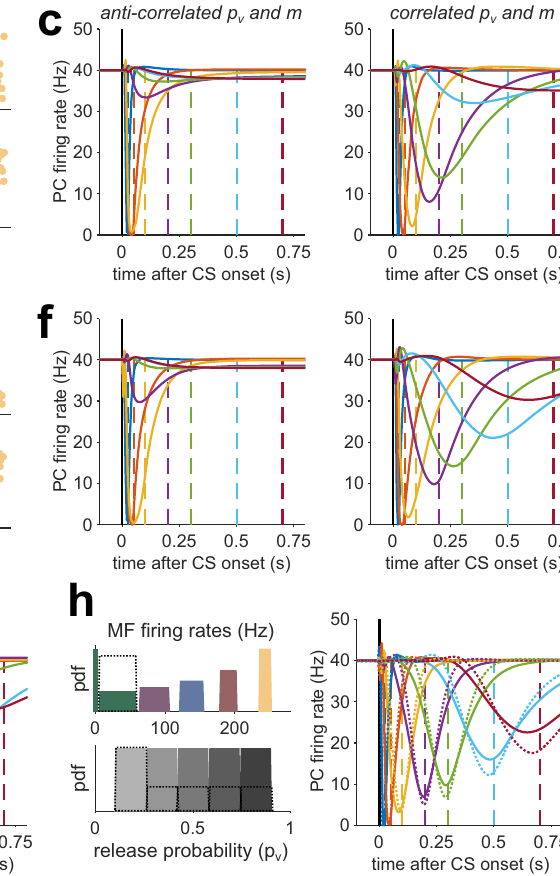
of n = 20 simulations with different realizations of MF patterns and MF-GC con- nectivity. d – f Same as ( a – c ), but for distributions divided into fi ve groups. g Left: MF rates and release probabilities for fi ve synapse types where the average group fi ring rate is as in ( d ), but the fi ring rate variance progressively decreases with the average rate. Right: resulting PC eyelid response learning for high correlations. h Same as( g ) but with zero-rate MFs addedto the lowest ratedistribution. Dashed lines indicate the case when the count of lowest rates and release probabilities is